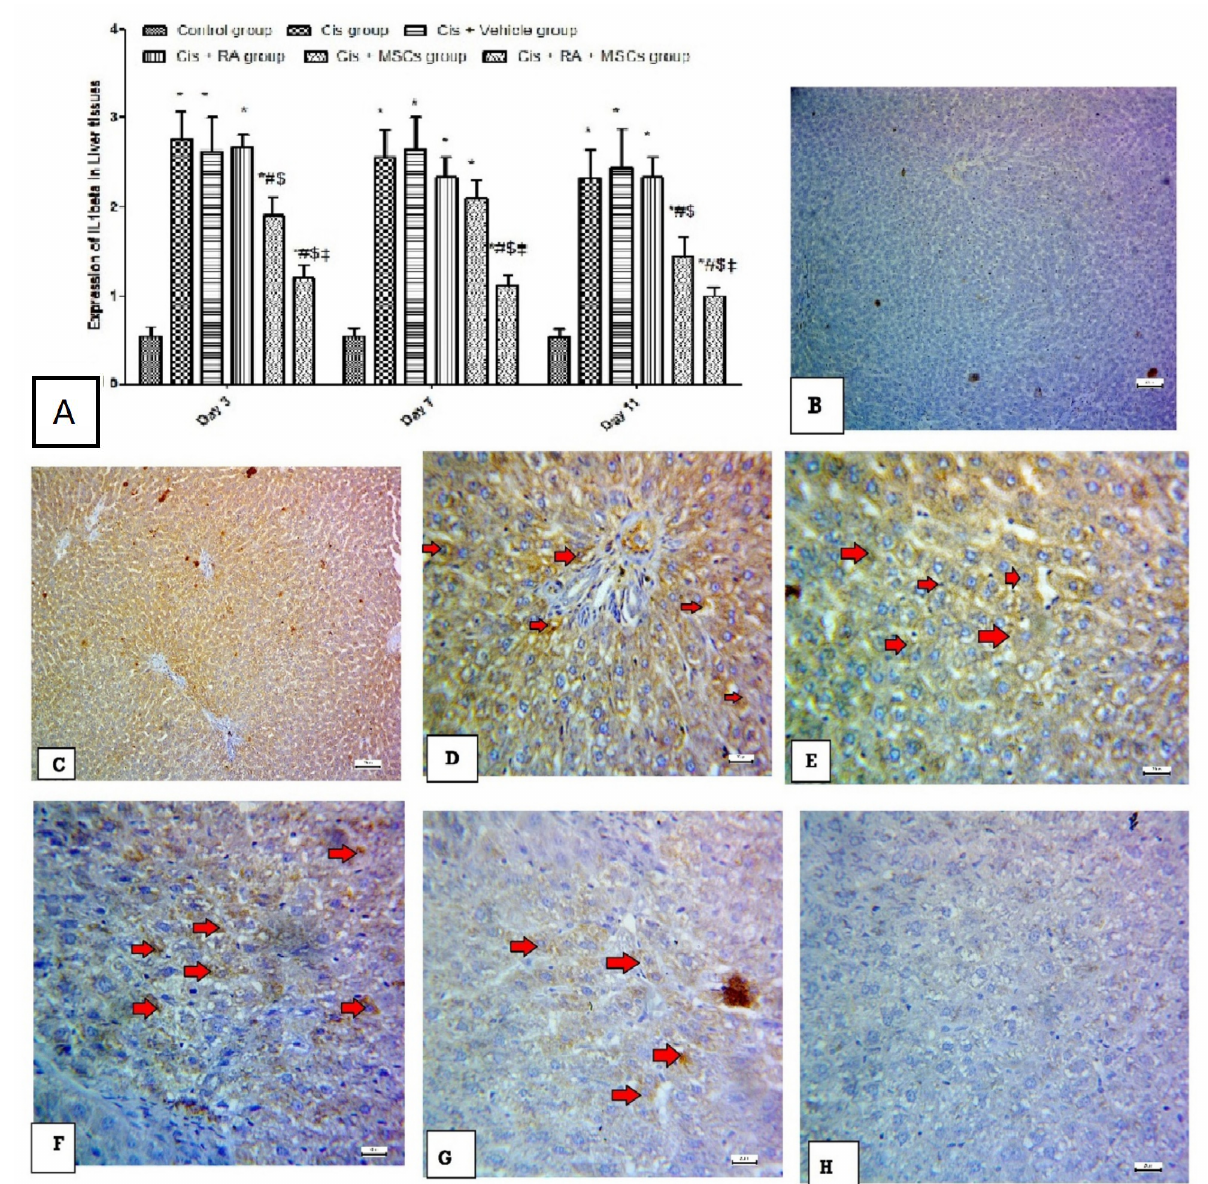
Figure 9. Immunohistopathological examination for the expression of IL-1beta in liver specimens. The score of Il1beta expression in liver at different time intervals (3 days, 7 days and 11 days) showed significant rise in its expression in Cis group and significant attenuation in all treated groups (Cis + RA, Cis + BM-MSCs and Cis + RA + BM-MSCs groups) ( A ). Microscopic pictures of im- munostained hepatic sections against Il1beta from rats groups sacrificed at day 11 showing negative staining in control group (( B ) 100 × ), increased positive brown expression of IL-1beta (red arrows) in hepatocytes in Cis group group at day 11 (( C ) 100 × and ( D ) 400 × ) and vehicle group ( E ) in contrast to treated groups where positive cytoplasmic brown expression (red arrows) in hepatocytes is moderate in group treated with RA group ( F ), MSCs group (( G ) 400 × ), to minimal expression in group treated with MSCs & RA group (( H ) 400 × ). * Significant vs. control group, # significant vs. Cis group, $ significant vs. Cis + MSCs group and ‡ significant vs. RA